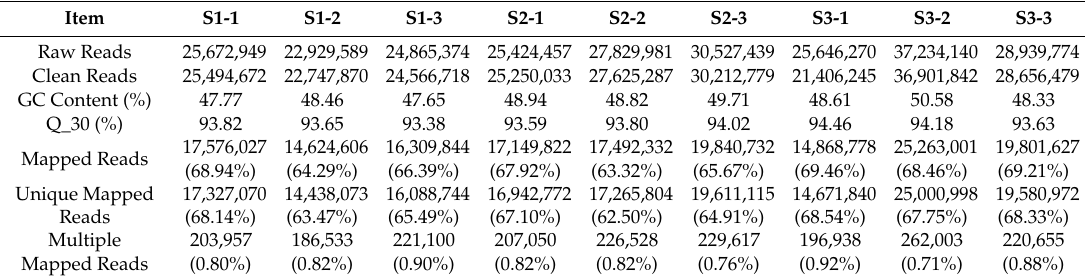
Table 1. Overview of the RNA-Seq results in developing tartary buckwheat seed.